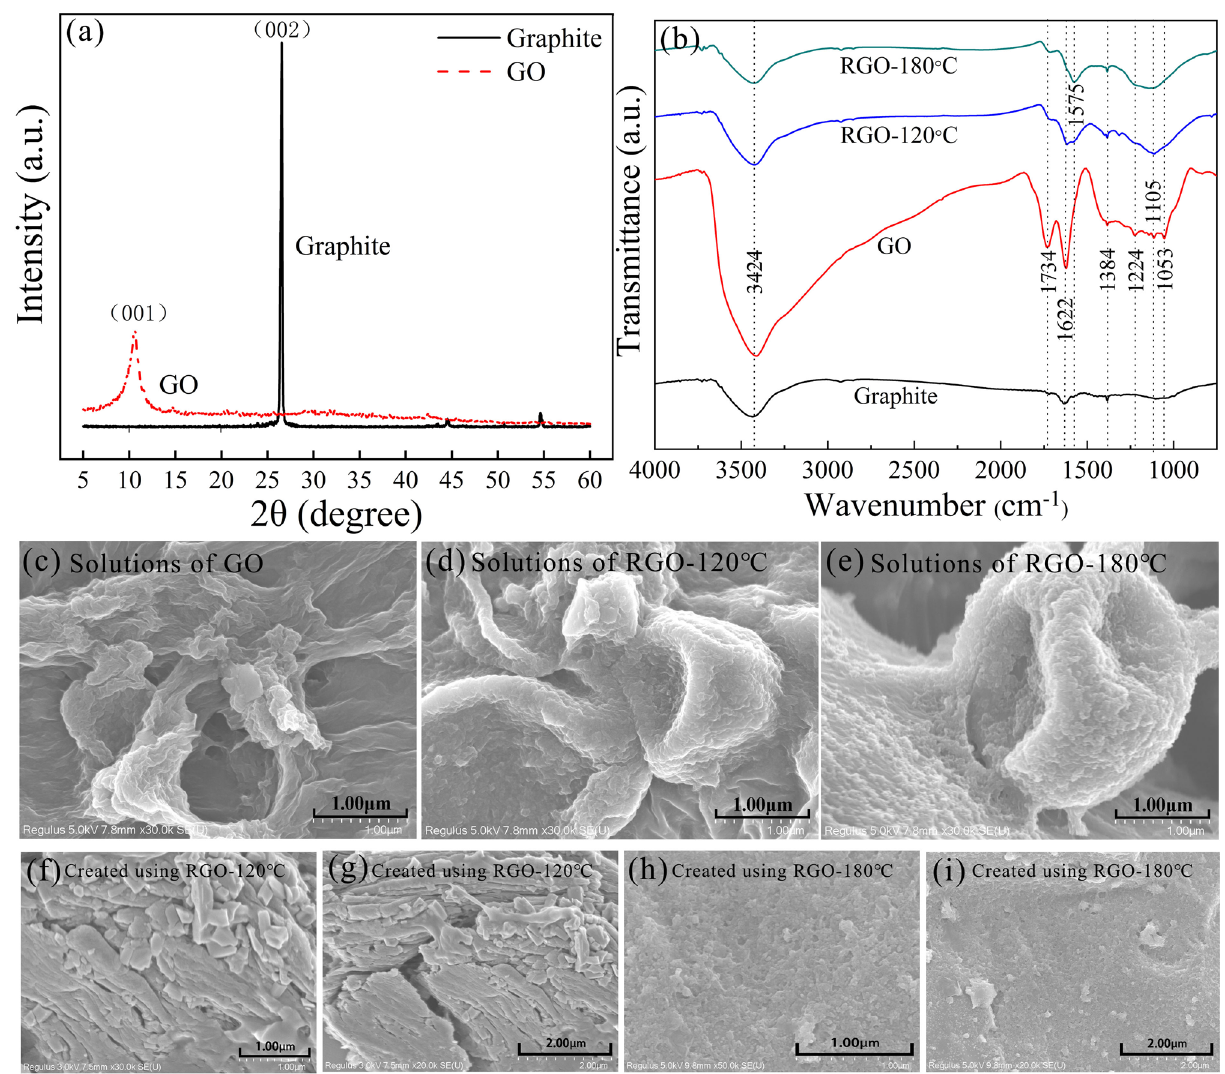
Figure 1. Evaluation of the sensitive layer. ( a ) XRD images for graphite and GO. ( b ) FTIR spectra for graphite, GO, RGO-120 °C and RGO-180 °C. ( c – e ) SEM images for ( c ) GO, ( d ) RGO-120 °C and ( e ) RGO-180 °C. ( f – i ) SEM images with different resolutions for sensitive layers created on LiNbO 3 substrates using ( f , g ) RGO-120 °C and ( h , i ) RGO-180